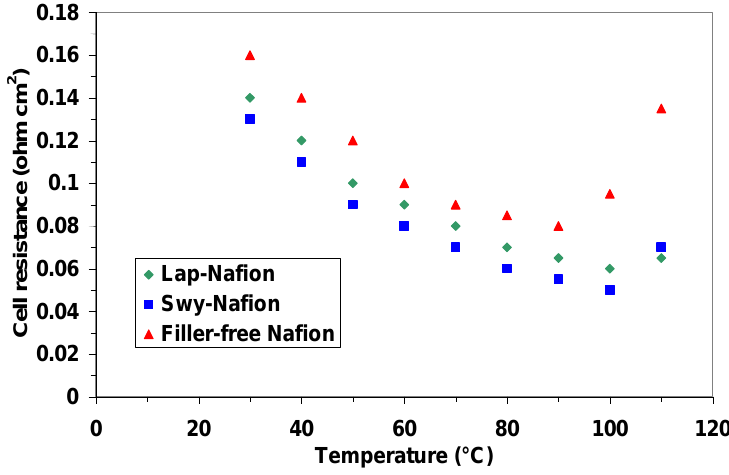
Figure 8. Cell resistance values as a function of temperature for the cells equipped with the different